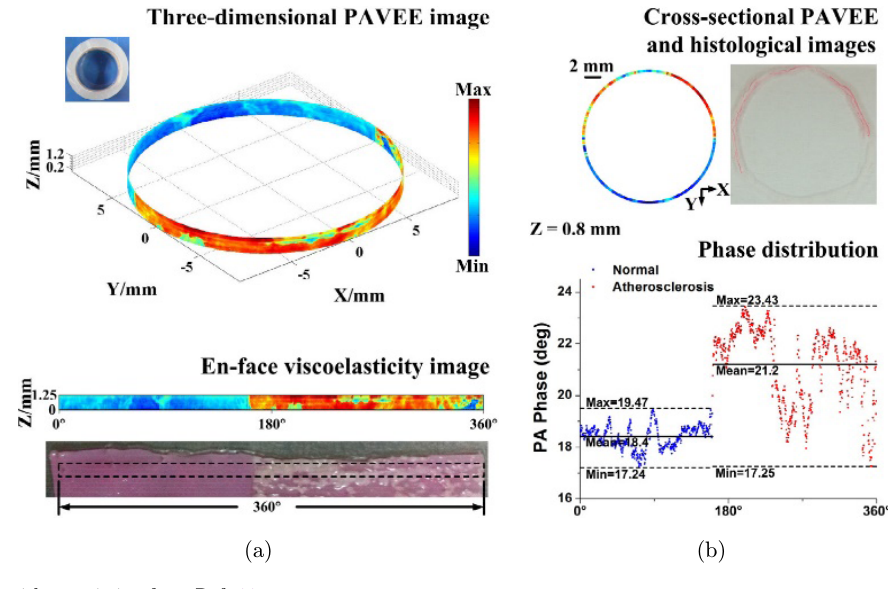
Source : Reproduced with permission from Ref. 44. Fig. 11. (a) Longitudinal PAVEE image and en-face viscoelasticity image viewed from inside over a 360 (cid:3) ¯eld of the sample. In the °attened tissue photograph, the region within dashed frame is the scanning area. (b) PAVEE section and corresponding histology and phase distribution at z ¼ 0 : 8 mm. The section was stained with Oil Red O (red) targeting